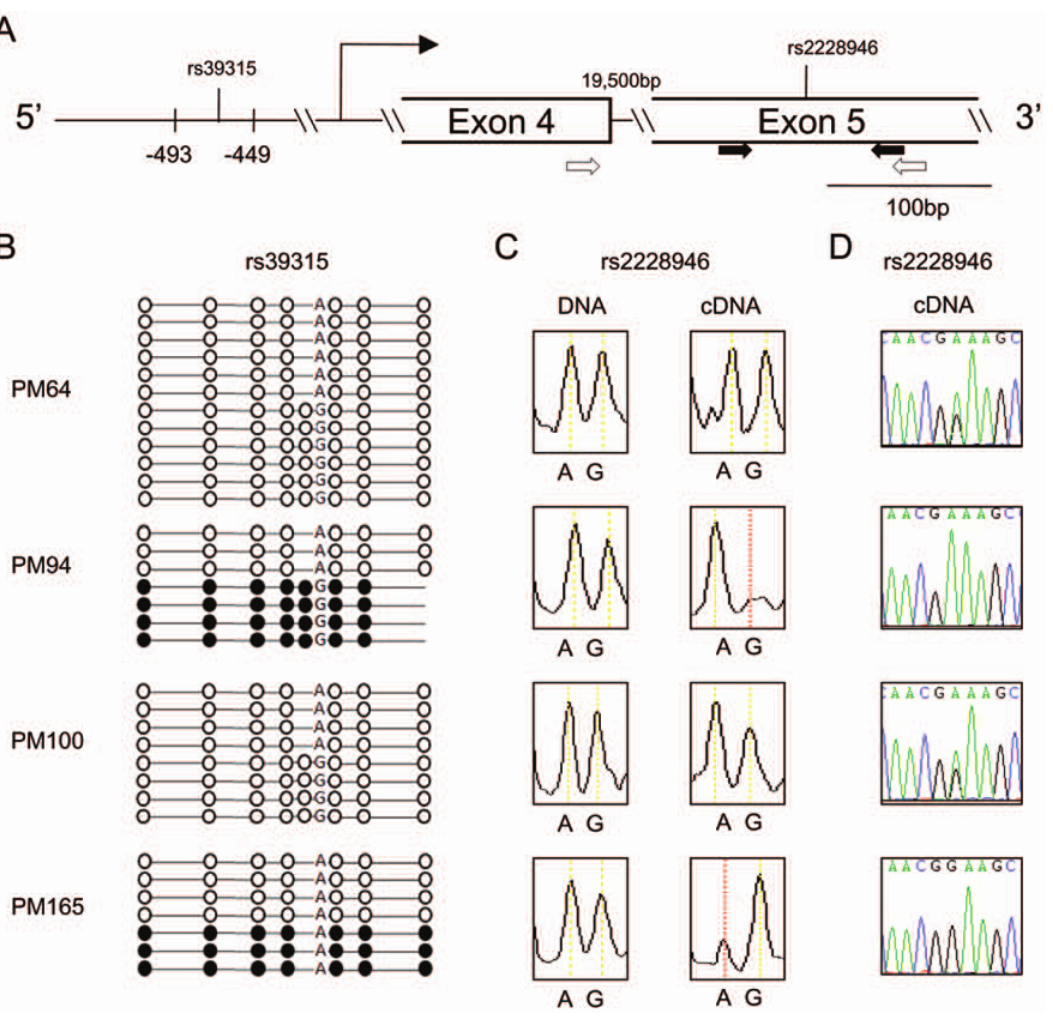
Figure 3. Allele-specific DNA methylation and mRNA expression of WNT2 . (A) Schematic of the WNT2 locus showing the regions investigated by clonal bisulfite pyrosequencing of the promoter ( 2 493 to 2 449 relative to the transcriptional start site according to NM_003391) and genotyping assays within exon 5. PCR primers for DNA and cDNA genotyping by iPlex are indicated by black arrows while RT-PCR primers for mRNA genotyping are indicated by arrows highlighted in white. (B) Bisulfite pyrosequencing of single clones from four placental samples. The A/G polymorphism of SNP rs39315 is indicated. Each row represents one clone and each circle represents one CpG. Methylated CpGs are shown in black while unmethylated CpGs are shown in white. The presence of a cytosine proximal to this A/G SNP site creates a polymorphic CpG site. (C) Allele- specific expression of WNT2 based on the analysis of the A/G allele of rs2228946 in DNA and cDNA by iPlex. Peak height of the alleles corresponds to the relative amount of alleles present in the sample. (D) Validation of allele-specific expression of WNT2 by cDNA-specific primers. Double peaks are observed in unmethylated samples while single peaks are found in methylated samples.